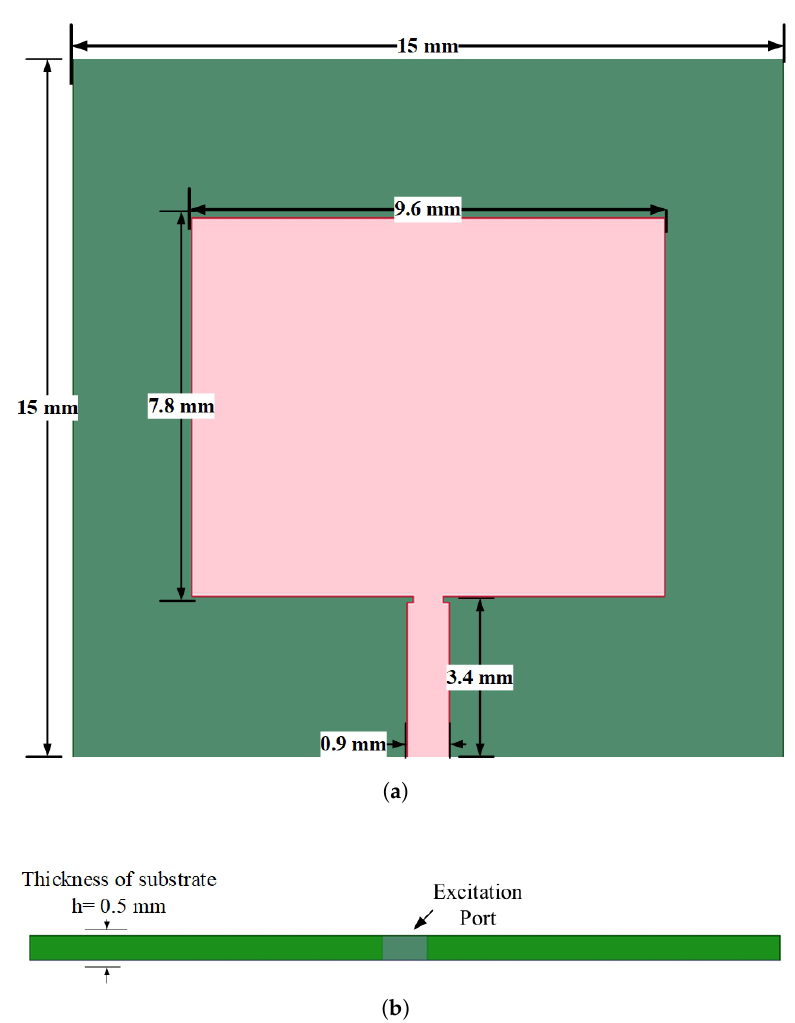
Figure 1. ( a ) Reference patch antenna model on a substrate (h = 0.5 mm, (cid:101) r = 2.2, tan δ = 0.0009) ( a ) top view, ( b ) side